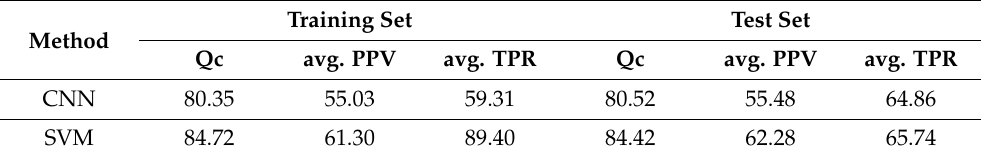
Table 6. Comparison of classification parameters for the CNN and SVM classifiers.